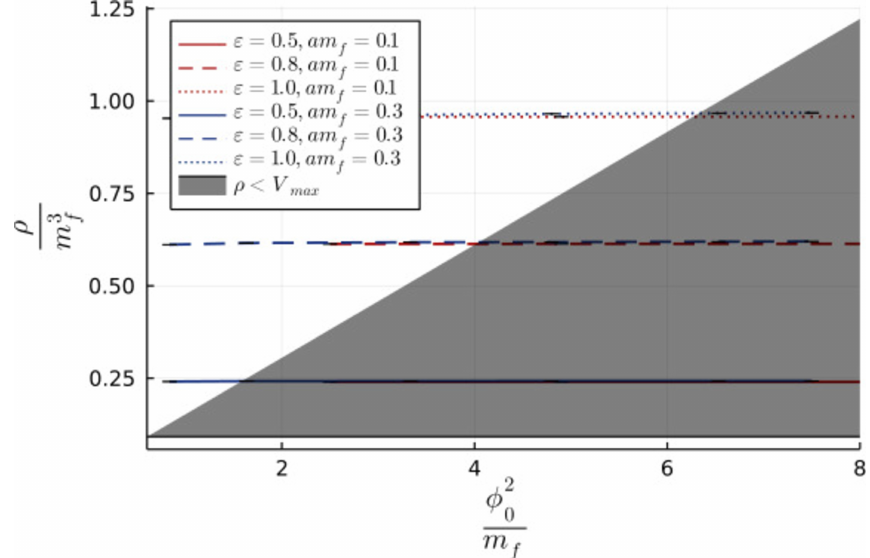
Figure 17 . The initial energy density for 2+1 dimensional configurations for different values of (cid:15) , φ 0 and cut-off am f . Configurations with (cid:15) = 0 . 5 can have a smaller average energy density than the potential barrier.